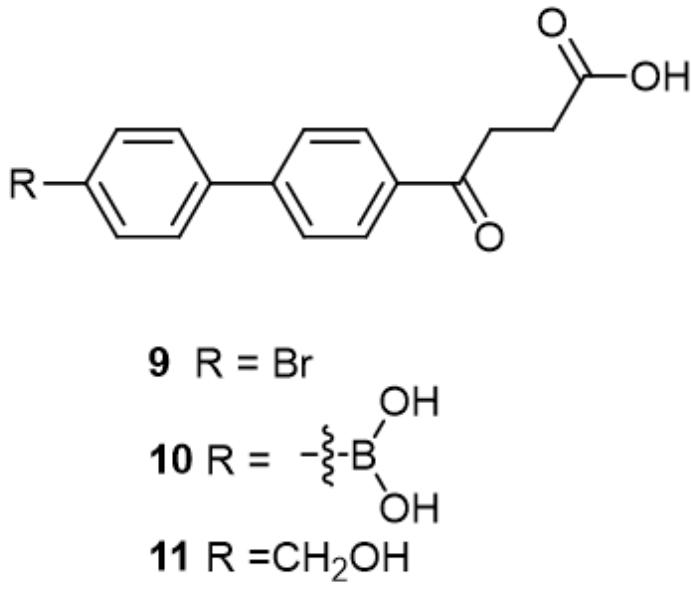
Figure 3. Additional fenbufen analogs involved in the present bioassays.